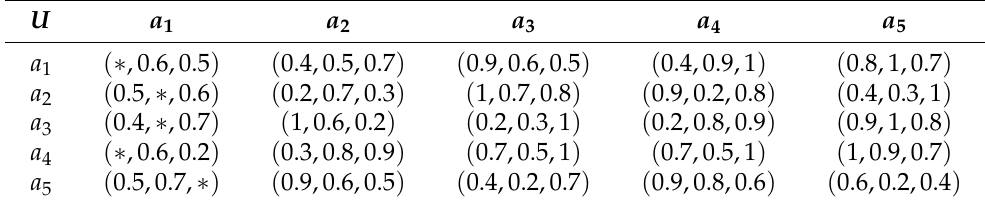
Table 4. The tabular representation of a three-way fuzzy relation R